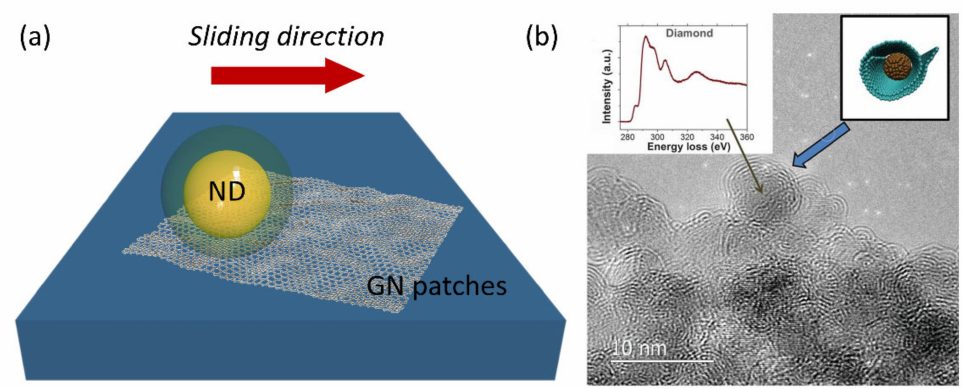
Figure 3. Superlubricity of NDs on GN due to formation of GN@ND scrolls. ( a ) schematic presen- tation of the superlubricity test; ( b ) TEM image of the resulting GN@ND scrolls with the electron energy loss spectrum recorded on the ND area. Reprinted with permission from [47]. Copyright 2015 The American Association for the Advancement of